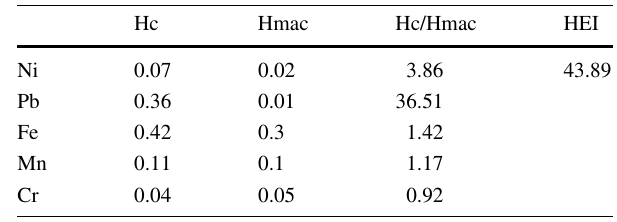
Table 8 Heavy metal evaluation index for groundwater at site 6